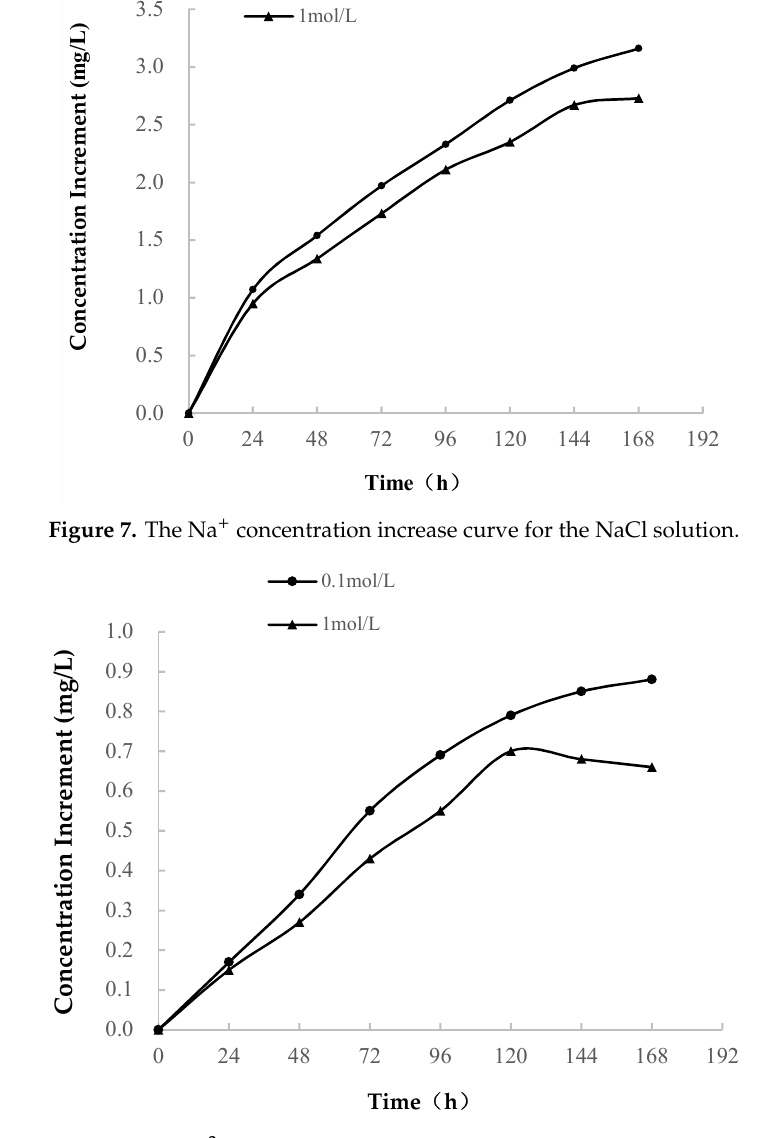
Figure 9. The Ca 2+ concentration increase curve for the CaCl 2 solution. According to the ion concentration increment curve for each solution, the increase in ion concentration gradually slows with time and tends to stabilize or even decrease, as shown in Figure 8 for example. In the 1 mol/L MgCl 2 solution, when the softening time reached 120 h, the concentration of Mg 2+ stopped increasing; on the contrary, there was a small decrease. It can be considered that in the beginning, the soft rock is softened mainly by the dissolution of soluble minerals, and the Mg minerals in the soft rock dissolve by the solution to form Mg 2+ . When rock softening has proceeded for approximately 120 h, the soluble minerals on the surface of the soft rock are almost completely dissolved. As a result, dissolution decreases, but the exchange of adsorbed ions is enhanced, and lattice replacement consumes the free Mg 2+ , which reduces the concentration of Mg 2+ in the solution; hence, there is a small decrease in the concentration. Because of the continuous actions of water and rock, mineral dissolution and ion exchange-adsorption always occur at the same